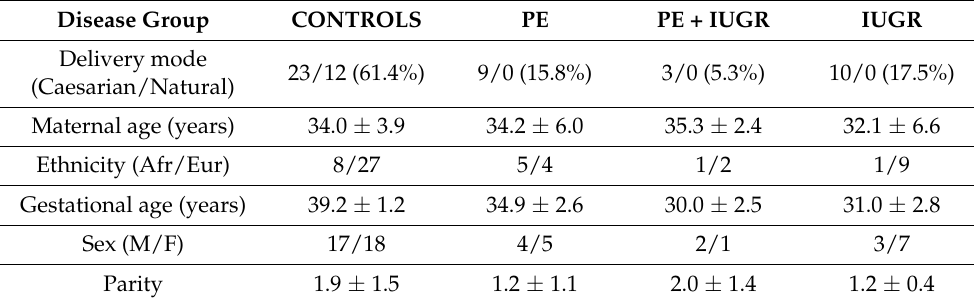
Table 1. Summary statistics of human placental samples sorted by disease